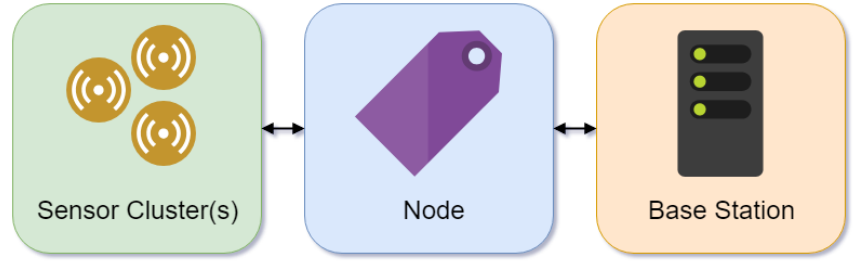
Figure 4. Wireless sensor network